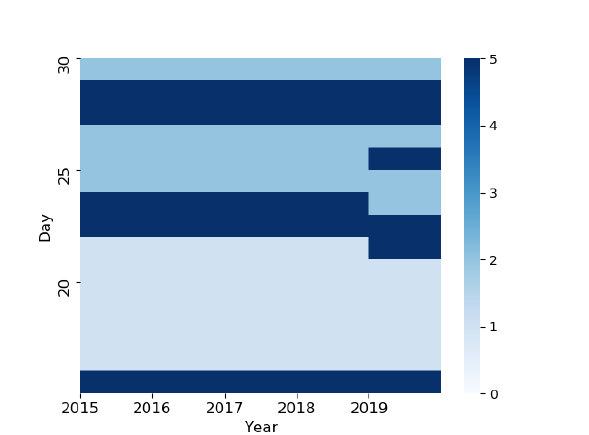
Figure 9: Clustering output for NO 2 for last 15 days in Q 3 over 2015 to 2019.